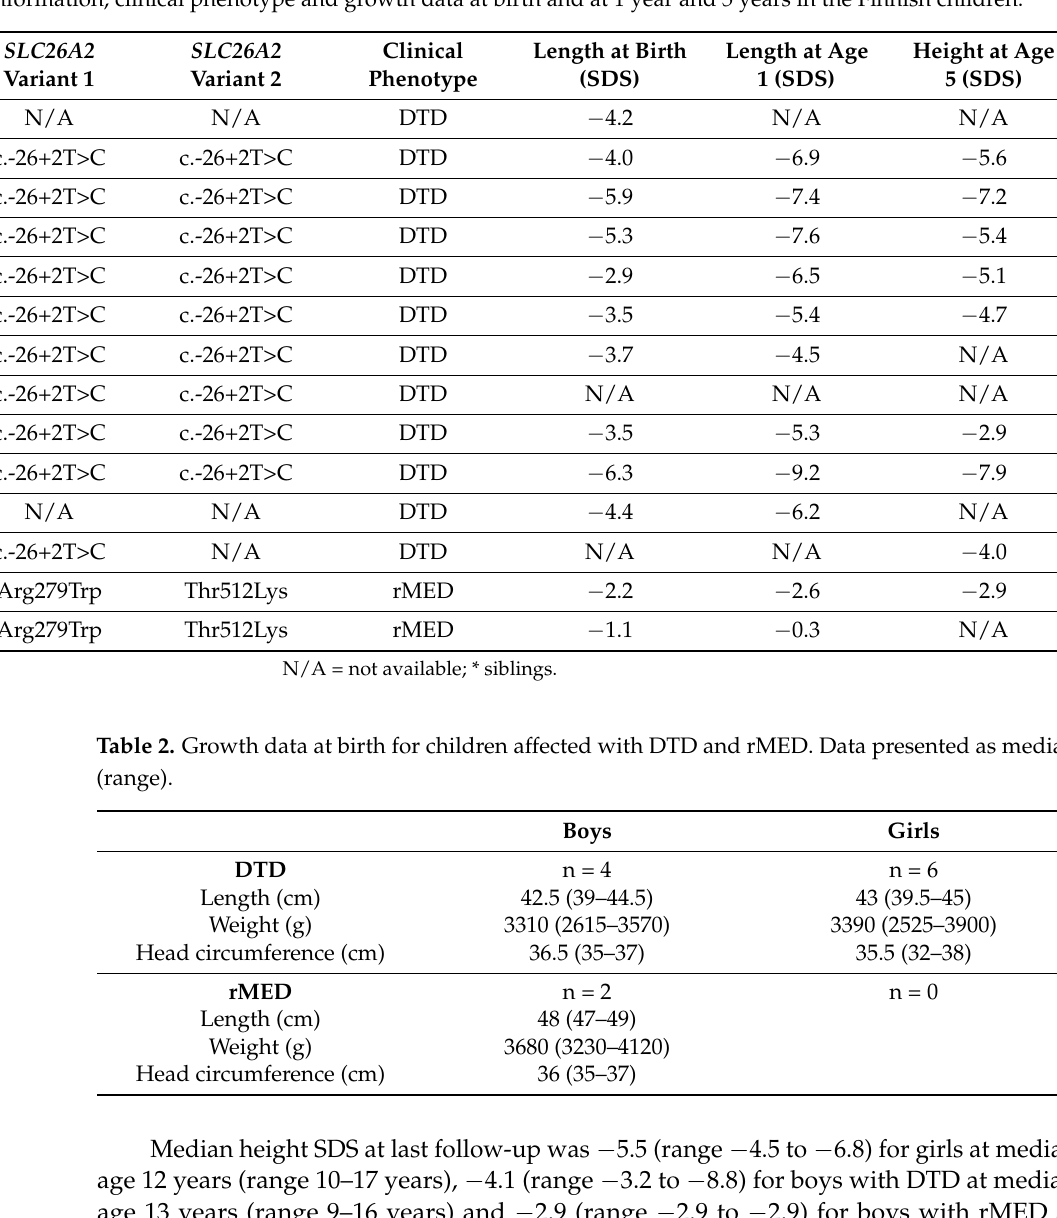
Table 1. Genetic information, clinical phenotype and growth data at birth and at 1 year and 5 years in the Finnish children.